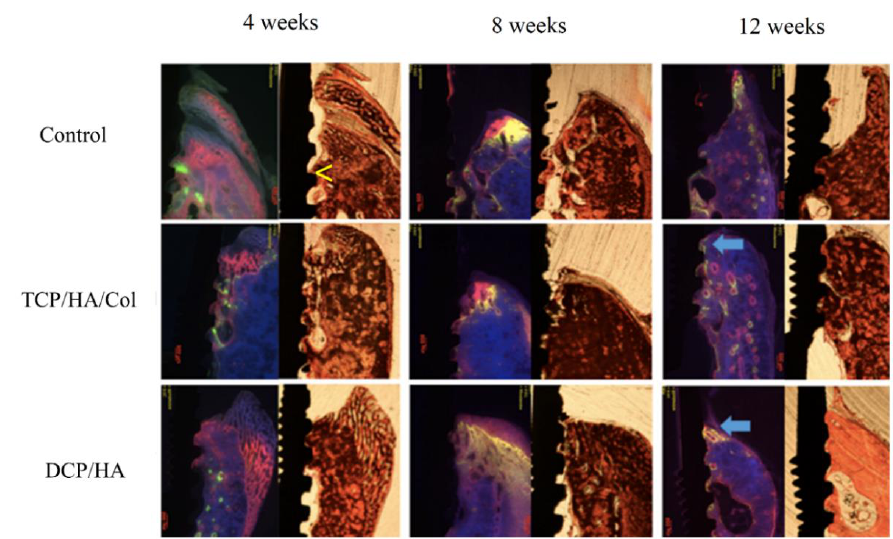
Figure 5. Original ground section and bone labeling indicating the healing process in each group at four, eight, and 12 weeks. At 4 weeks, moderate marginal bone loss (MBL) at the lower uppermost point of the marginal bone along the interface between the implant (yellow arrow) was observed in the control group; however, initially prominent bone remodeling activity (yellow-green in color immediately after surgery) was observed near the interface between the alveolar bone and the implant. The initiation of subperiosteal reaction contributed to bone remodeling (red in color at 2 weeks after surgery) and was observed as early as 2 weeks thereafter. At 8 weeks, moderate MBL was observed in the ground section. However, prominent bone remodeling activity in the subperiosteal region was observed at 4 and 6 weeks after surgery, with high-intensity bone labeling using calcein green (yellow-green in color at 4 weeks) and alizarin complexone (red in color at 6 weeks). At 12 weeks, marked bone loss was observed in the ground section, and a decline in the intensity of bone labeling at both 8 weeks (yellow-green in color at 4 weeks) and 10 weeks (red in color) indicated that bone remodeling had gradually decreased. In the TCP/HA/Col group, the more marginal bone was maintained than in the control group at four, eight, and 12 weeks. The initial bone remodeling that occurred at the interface between the alveolar bone and implant (yellow-green in color immediately after surgery), as well as the subperiosteal region (red in color at 2 weeks after surgery), was substantially similar to that of the control group. Sustained active bone remodeling was observed in the subperiosteal region 4 and 6 weeks after surgery, with moderate-intensity bone labeling using calcein green (yellow-green in color at 4 weeks) and alizarin complexone (red in color at 6 weeks). The area and intensity of bone labeling gradually increased at 8 weeks (green in color) and 10 weeks (red in color), indicating that subperiosteal bone remodeling was still in progress. More woven bone formed after a prolonged subperiosteal reaction. Moreover, weak bone labeling at the top of the marginal bone at 8 weeks (green in color) and 10 weeks (red in color) was observed adjacent to the implant (arrow), suggesting that the bone remodeling activity was initiated only at the uppermost point of the marginal bone adjacent to the implant. In the DCP/HA group following surgery, the initial prominent bone activity was observed near the alveolar bone, implant, and bone graft, initially similar to the control group. Initiation of the periosteal reaction contributing to new bone formation was also observed 2 weeks thereafter. Stronger bone remodeling activity and a greater level of woven bone formation were observed as soon as this subperiosteal reaction occurred (2 weeks), compared with the control and TCP/HA/Col groups. Diffused high-intensity bone labeling using alizarin and calcein green in the periosteal region was prolonged for 4 weeks after surgery. The intensity of bone labeling was sustained and then gradually decreased at 6 weeks, indicating that bone remodeling activity peaked and then gradually decreased. At 8 and 10 weeks, intensive bone labeling at the top of the marginal bone adjacent to the implant was observed to be ongoing. Denser lamellar bone formation was observed in the DCP / HA group than in the other two